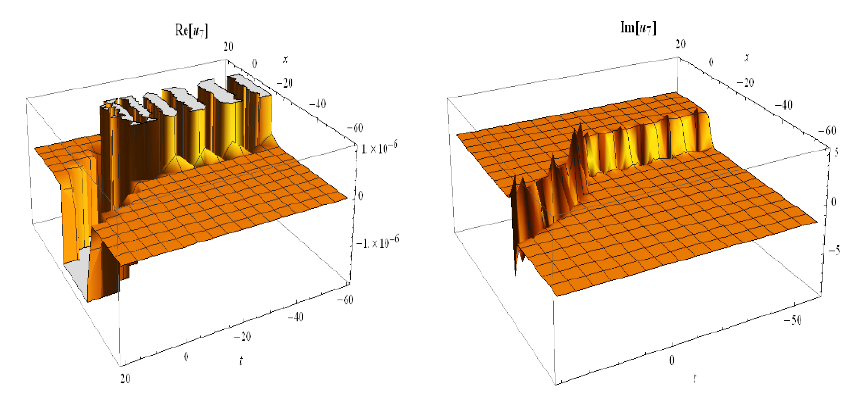
Figure 16. Three-dimensional graphs of imaginary and real part of (35).